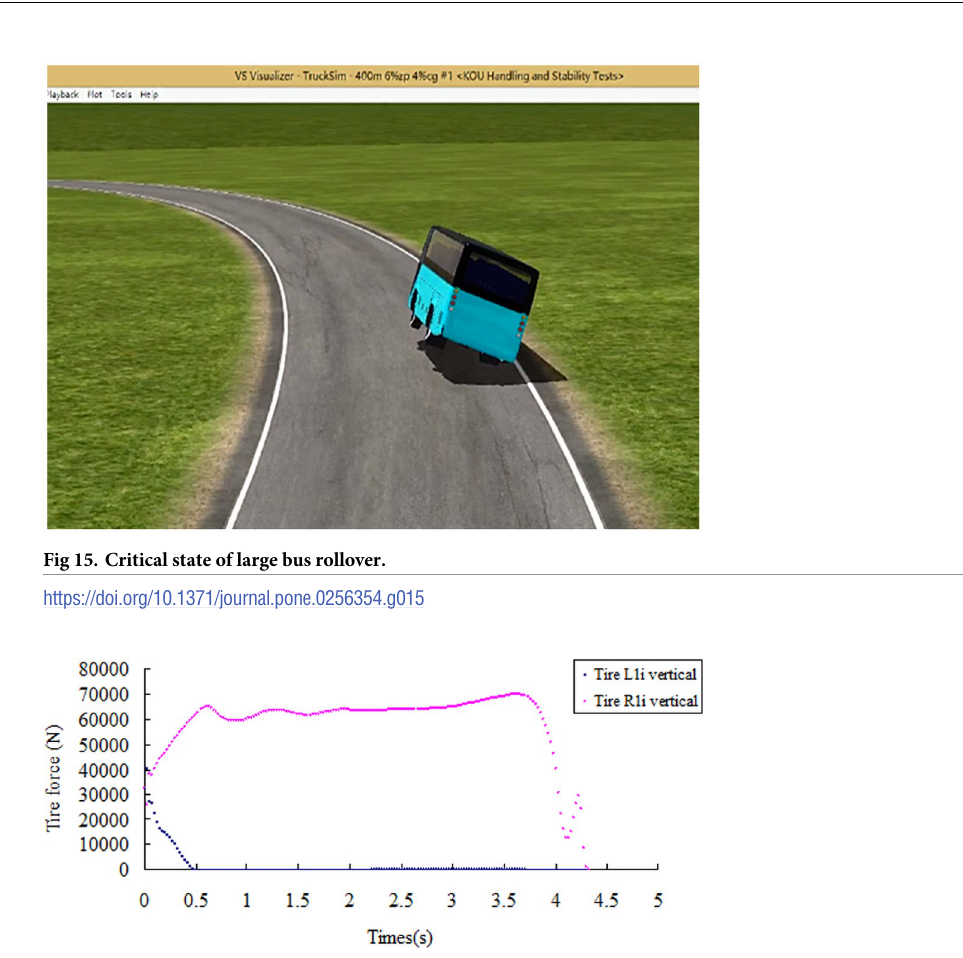
Fig 16. Vertical reaction curve of the front axle tire with a friction coefficient of 0.8.